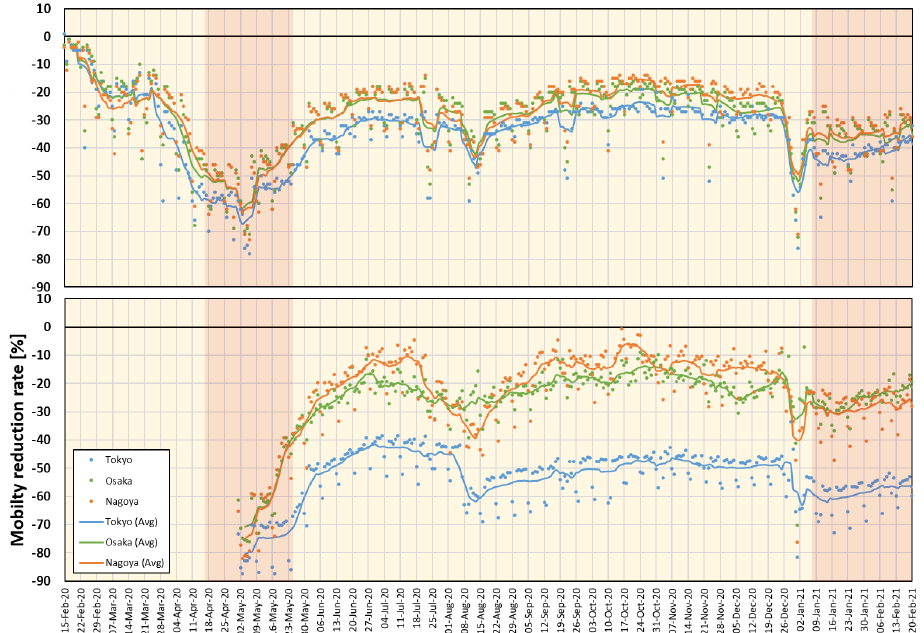
Figure 2. Mobility reduction rate according to the Google mobility report ( top ) and DoCoMo mobile usage ( bottom ) in Tokyo, Aichi (Nagoya main station), and Osaka. Red regions demonstrate the time for Japan’s national state of emergency. Lines represent a 7-day